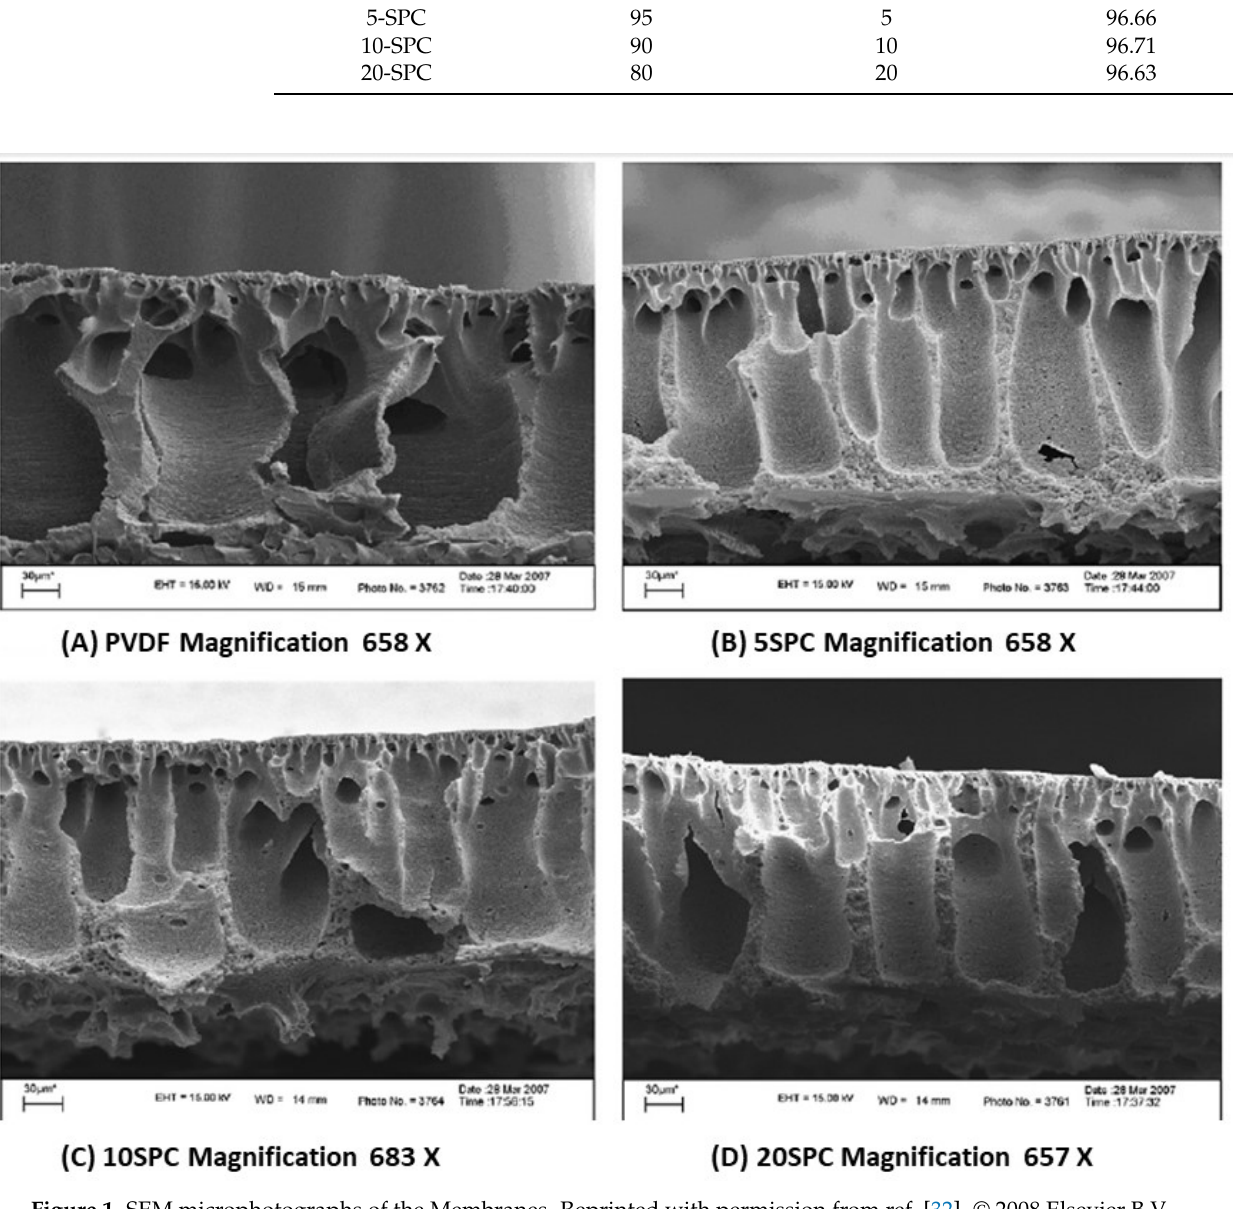
Figure 1. SEM microphotographs of the Membranes. Reprinted with permission from ref. [32]. © 2008 Elsevier B.V. Table 2. The Weight percent relation SPC/PVDF and its oil rejection coefficient for the mem- branes. Reprinted/Adapted with permission from ref. [32]. © 2008 Elsevier B.V.